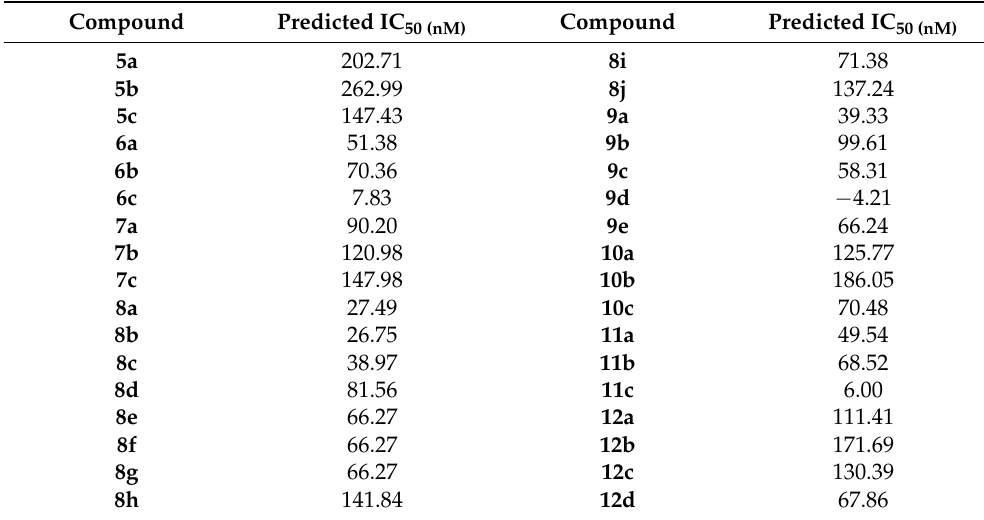
Table 1. The predicted PDE5 IC 50 values of the test set (series A – H ) in